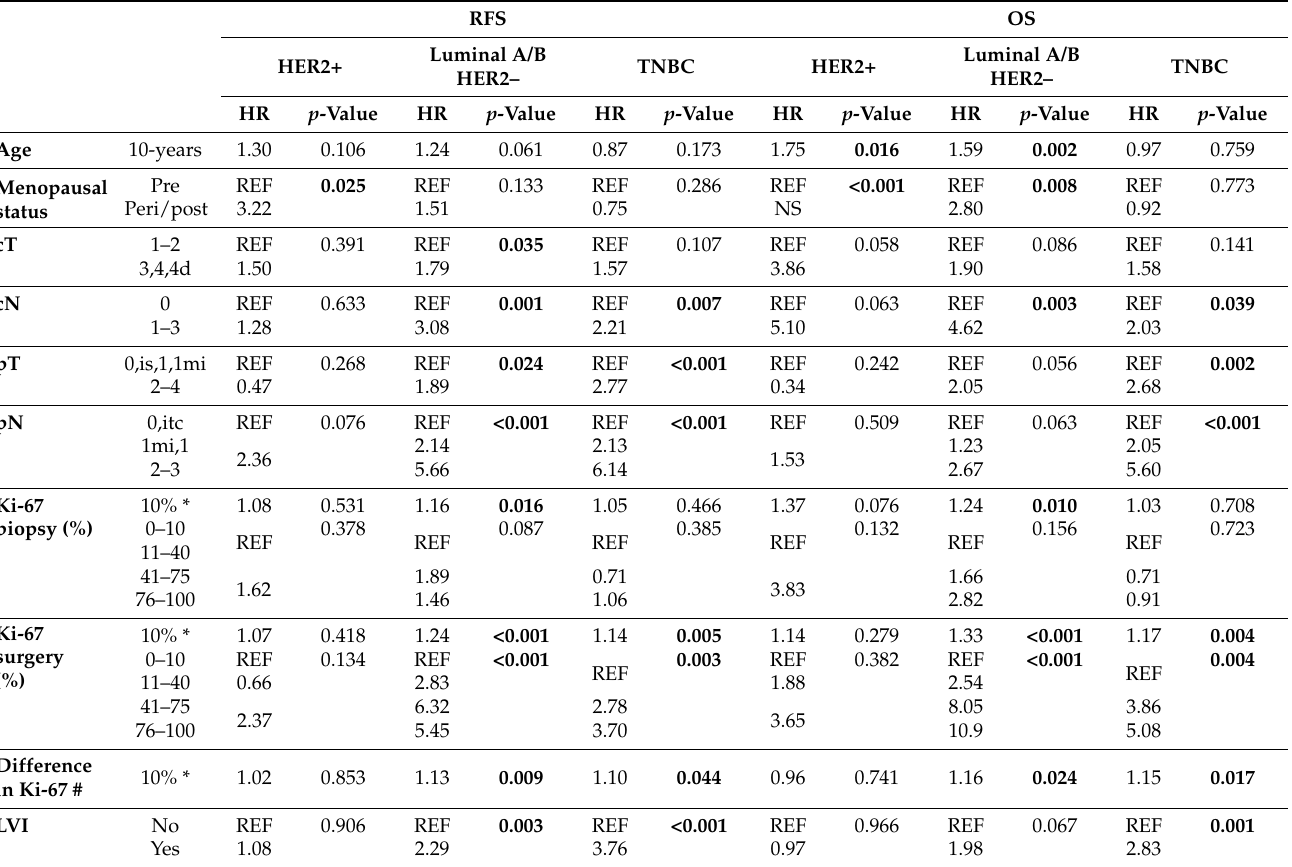
Table 4. Univariable analysis of the association of clinical and pathological pre- and post-NAT characteristics with RFS and OS according to BC subtypes.